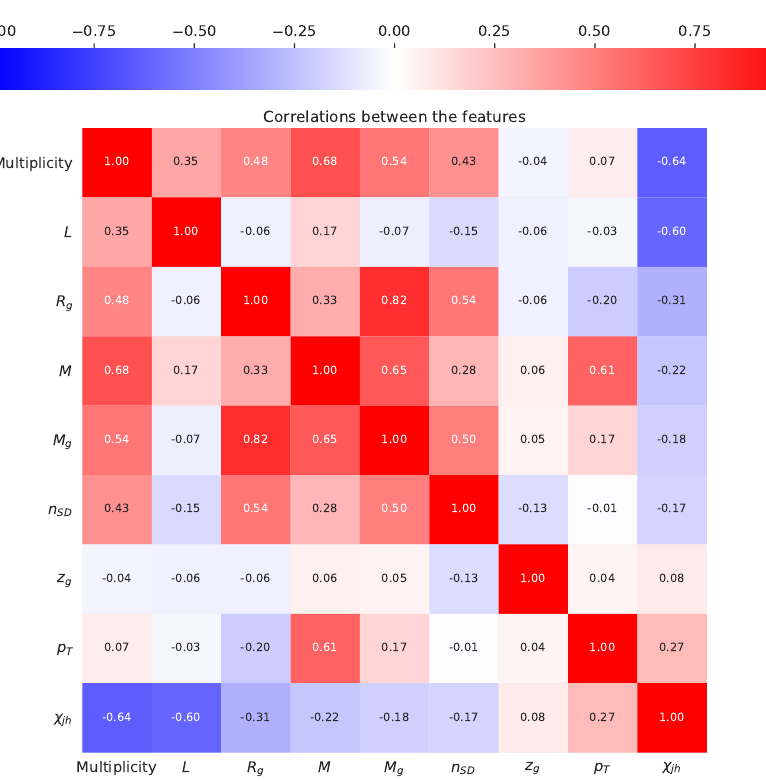
Figure 21 . Pearson correlation coefficient matrix between jet